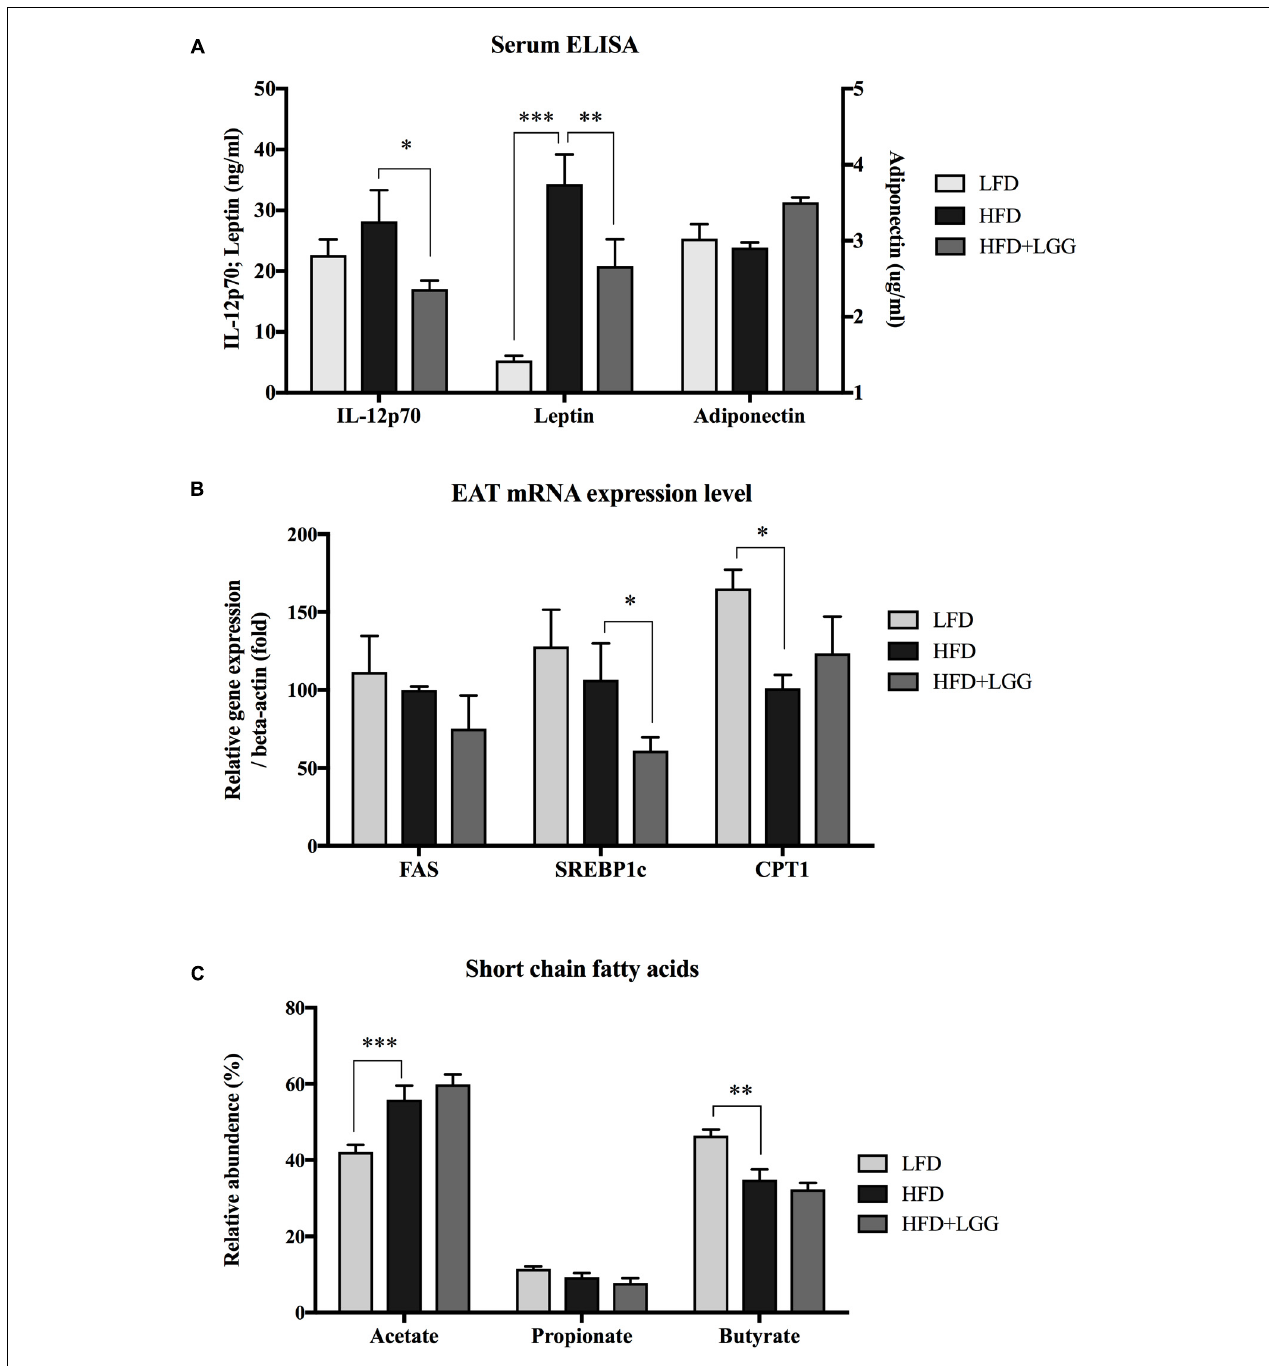
FIGURE 3 | (A) Serum IL-12p70, leptin and adiponectin were measured using the ELISA method. (B) mRNA expression level of fatty acid synthase (FAS), sterol regulatory element-binding protein 1c (SREBP1c) and carnitine palmitoyltransferase 1 (CPT1) were measured from epididymal adipose tissue (EAT). (C) Short chain fatty acids from fecal samples of each group were measured by gas chromatography. Significance level was calculated by using ANOVA and Bonferroni’s multiple comparisons test; results are illustrated as ∗ p < 0.05, ∗∗ P < 0.01, ∗∗∗ P < 0.001.